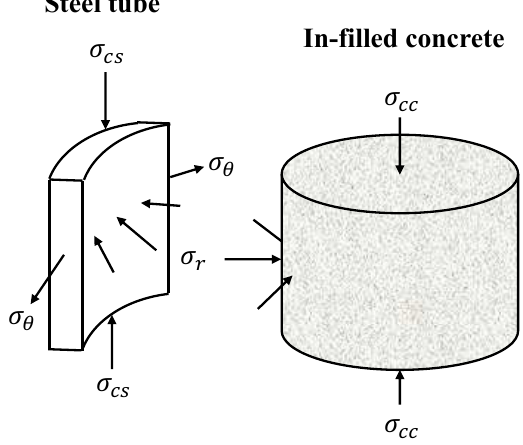
Figure 1. Composite actions in CCFST stub columns under axial